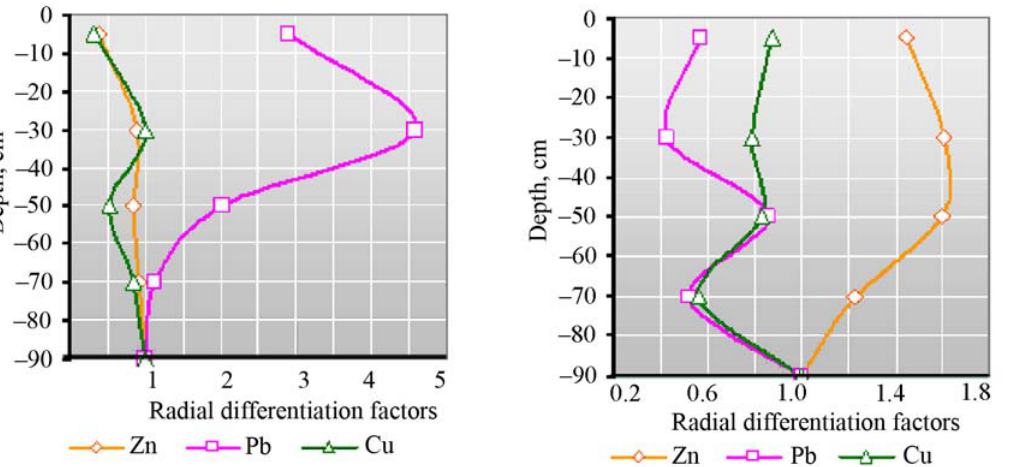
Fig. 6. Heavy metals in forest soil profile diferentiation Fig. 7. Heavy metals in first grassland soil profile diferentiation